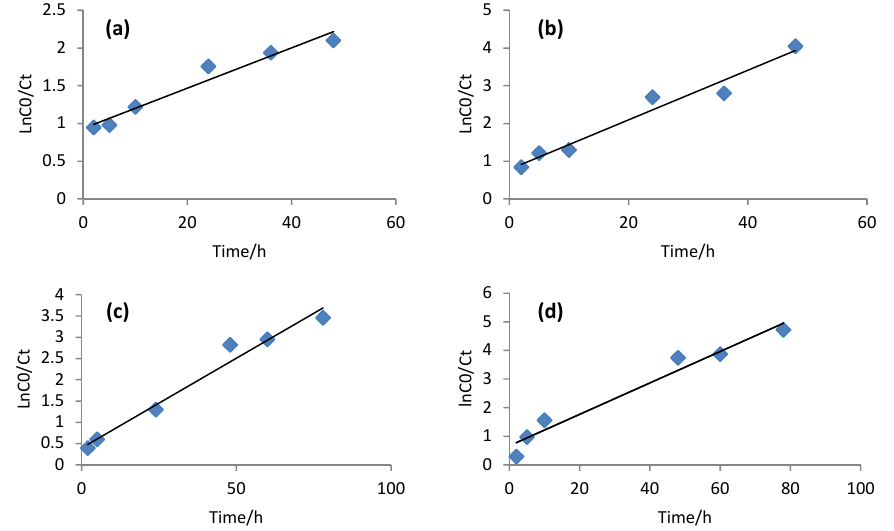
Fig.5: 1 st order kinetic plot at different dye concentrations: (a) 25 mg/L, (b) 100 mg/L, (c) 200 mg/L and (d) 500 mg/L